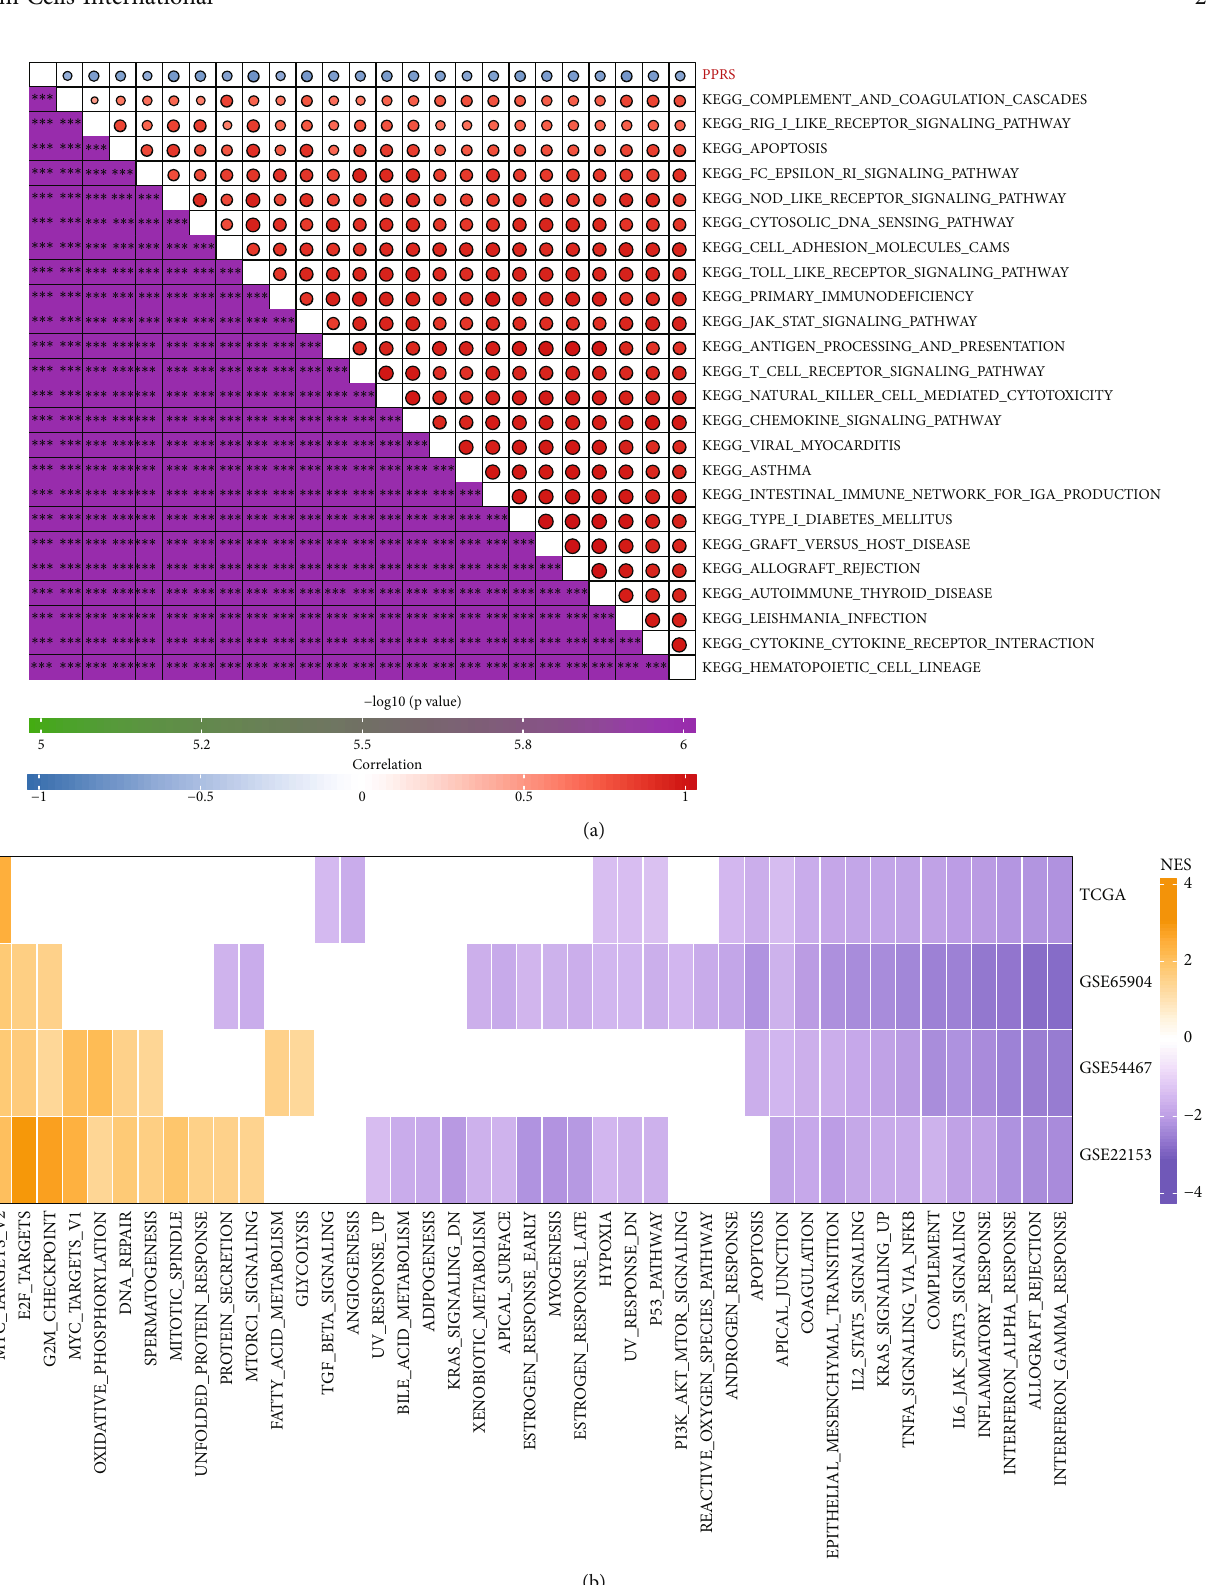
Figure 7: The relation between pathways and PPRS. (a) Correlation analysis between PPRS and KEGG pathways through ssGSEA. (b) A heat map demonstrating normalized enrichment scores (NESs) of pathways in MSigDB calculated by comparing PPRS-high with PPRS-low groups (with a false discovery rate (FDR) of <